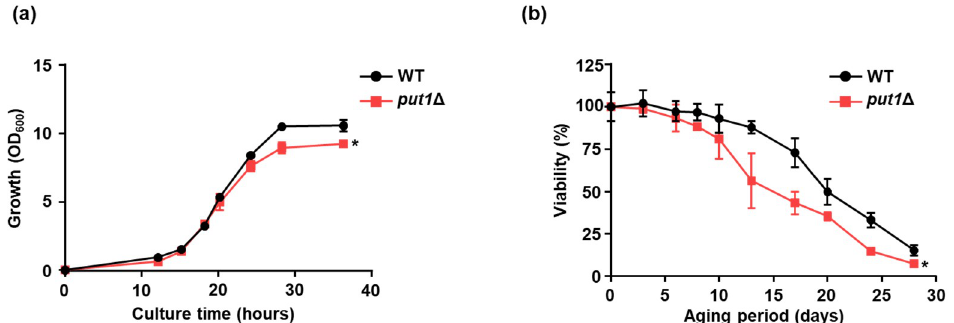
Figure 1. Phenotype analysis of put1 ∆ strain. ( a ) Growth curves of WT and put1 ∆ . Cell growth was determined at the indicated time points by measuring OD 600 . Data are presented as means ± SD ( n = 3) and statistical significance was determined by two-way ANOVA with Tukey’s test. * p < 0.05, vs. WT. ( b ) Chronological survival curves of WT and put1 ∆ . Chronological lifespan was determined by colony formation units. Data are presented as means ± SD ( n = 5) and statistical significance was determined by two-way ANOVA with Tukey’s test. * p < 0.05, vs. WT.